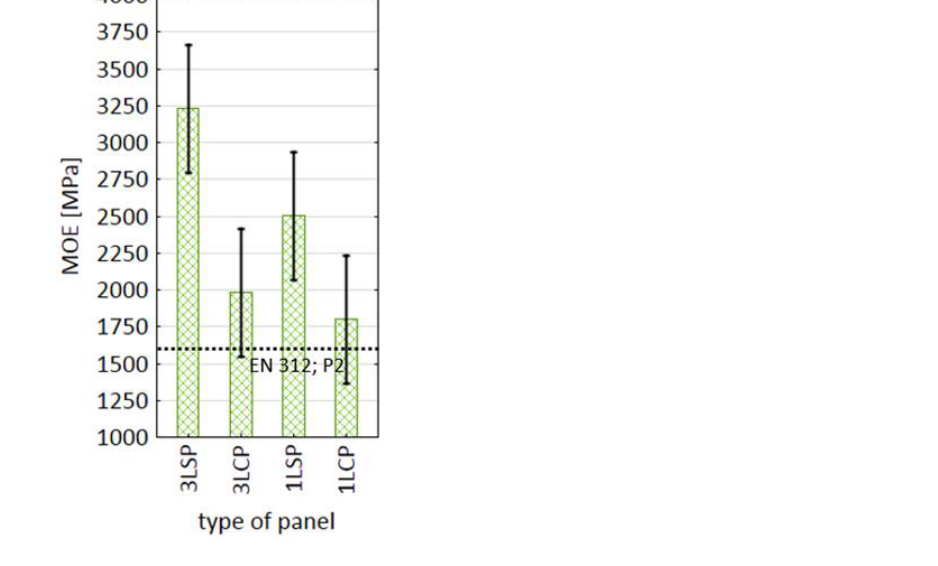
Figure 9. Modulus of elasticity (MOE) of measured particleboards (PBs). 3LCP—three-layer cup- plant PB, 3LSP—three-layer spruce PB, 1LCP—single-layer cup-plant PB, and 1LSP—single-layer spruce PB ( n =